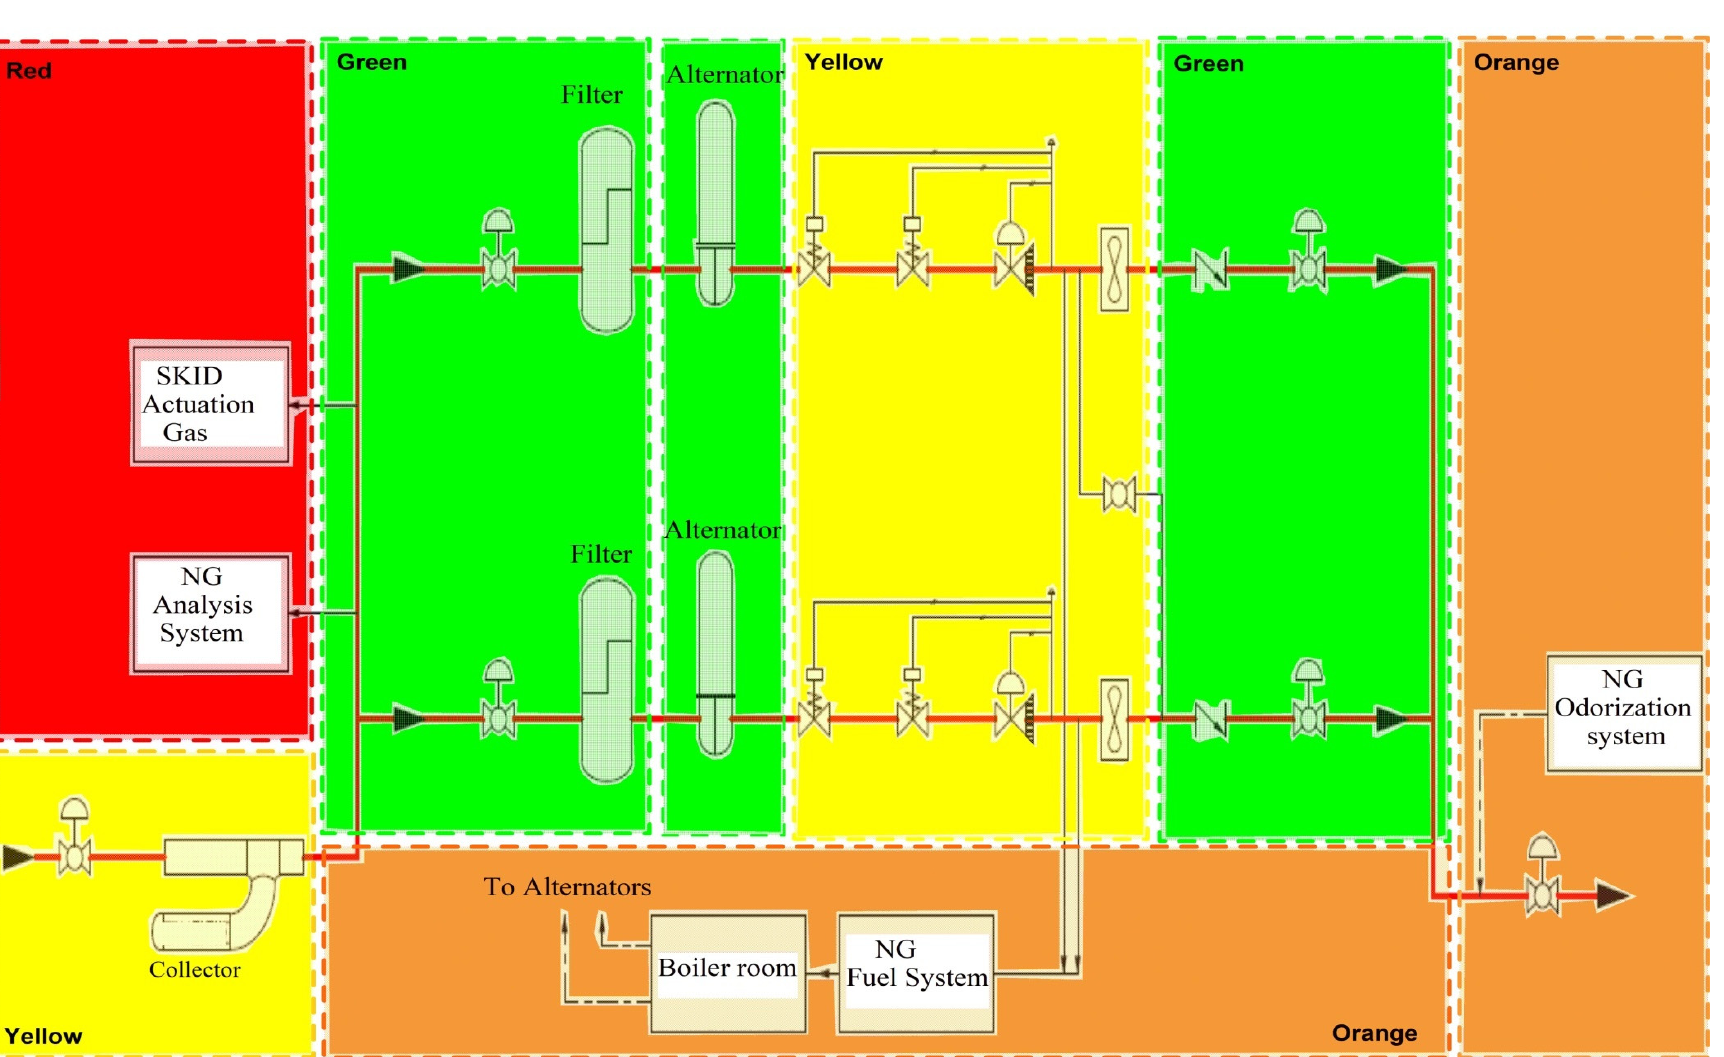
Figure 8. The SCM map generated by the cooperative HAZOP-DMRA-SCM technique at the workplaces of an MRS/GTS.